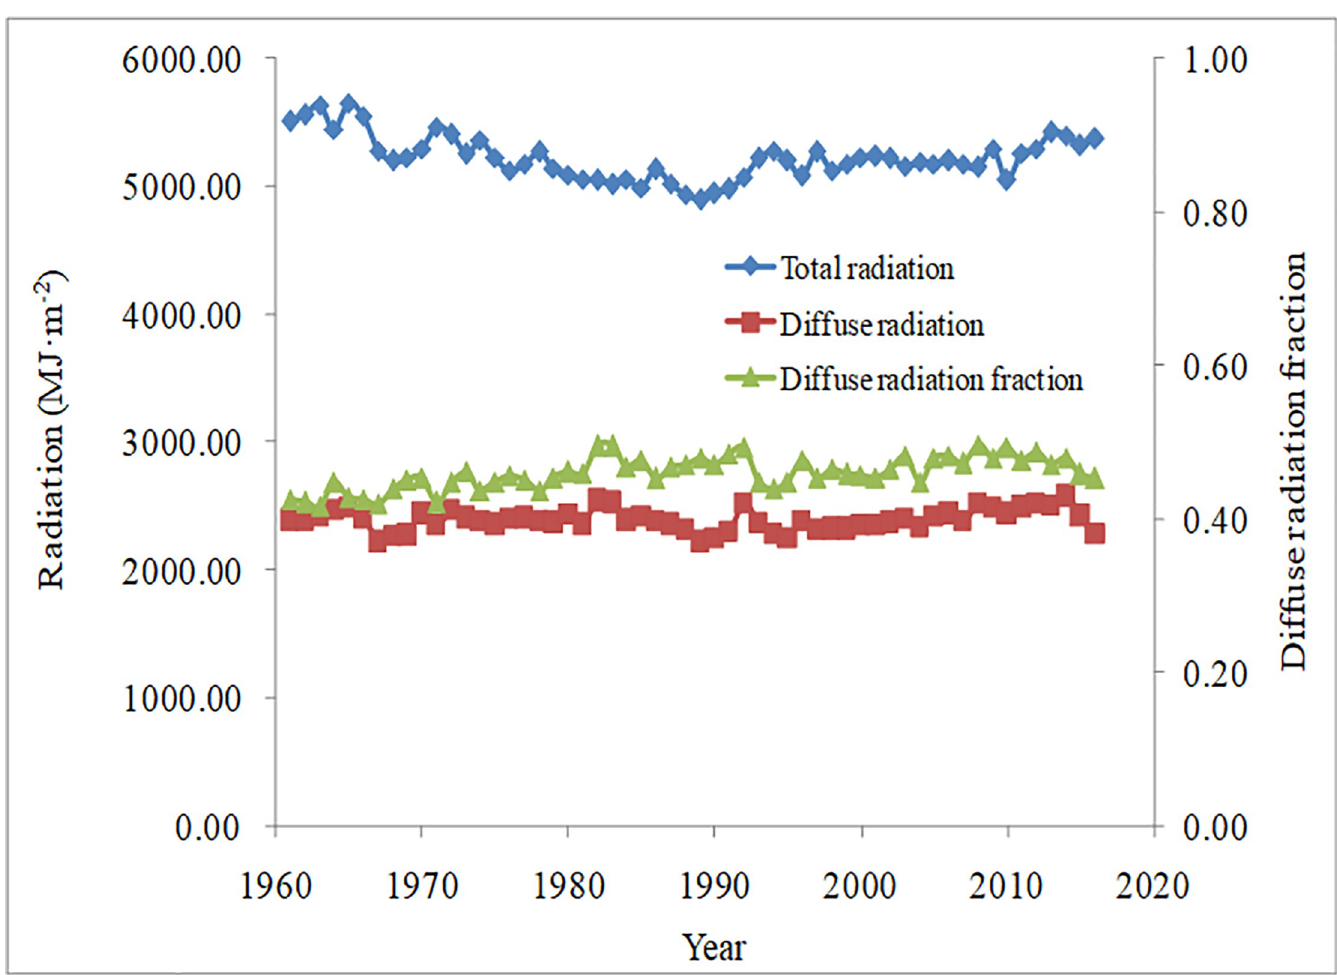
Fig 4. Changes in total radiation, diffuse radiation, and diffuse radiation fraction in China from 1961 to